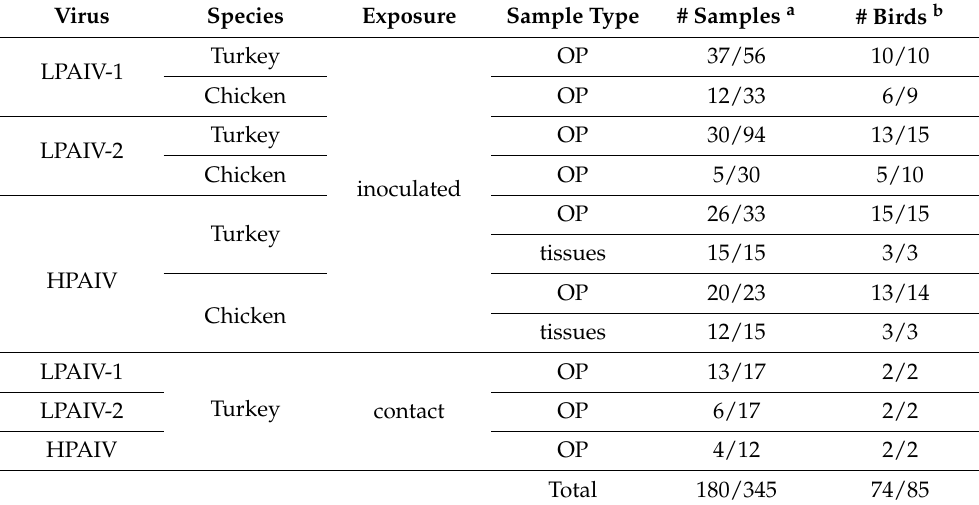
Table 1. Samples sequenced for this